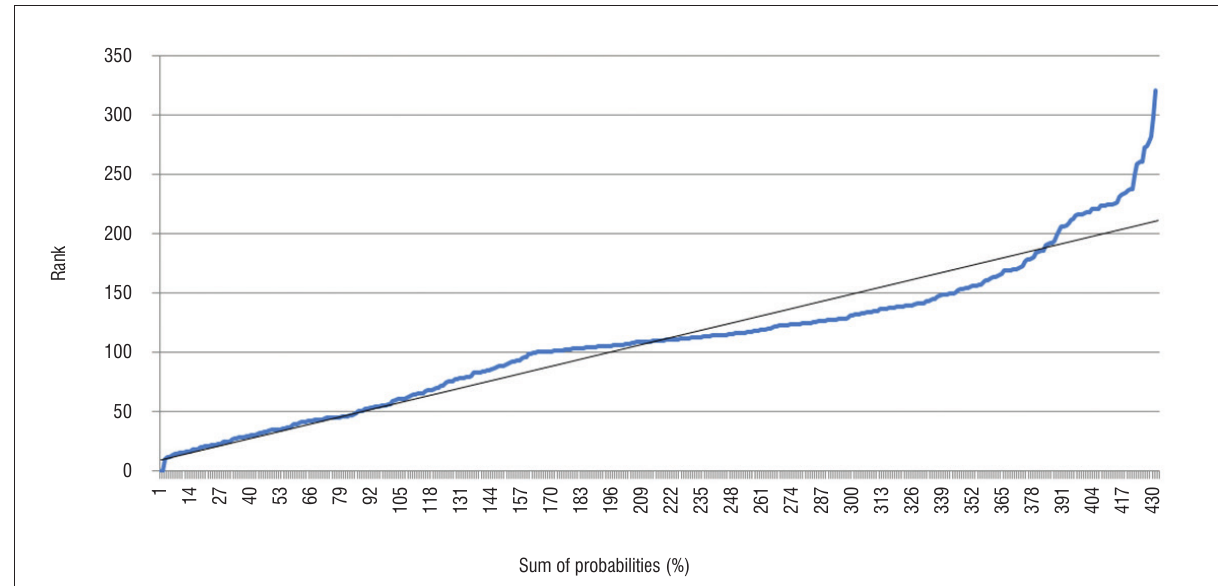
Sum of probabilities Figure 2: Sums of probabilities in increasing order vs rank for all stations and seasons combined. The straight line represents the least-squares linear fit between the rank and the sum of probabilities.